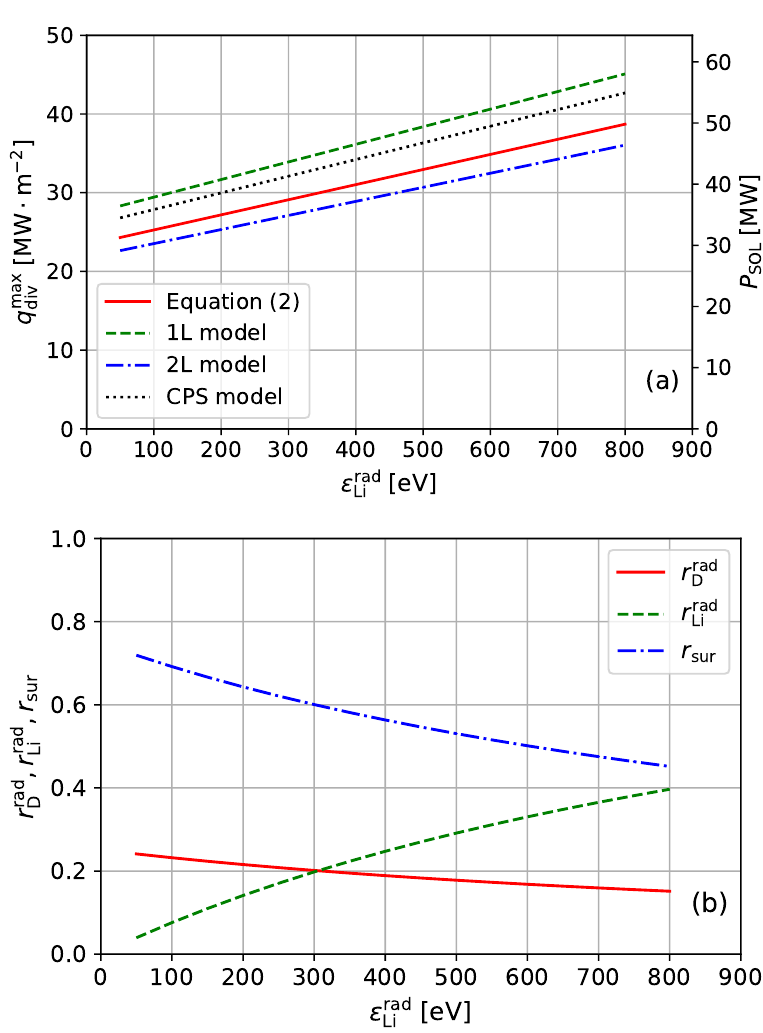
Figure 6. The maximum tolerable heat load q max line), r rad (the green dashed curve), r sur (the blue dash-dotted curve) as functions of the Li